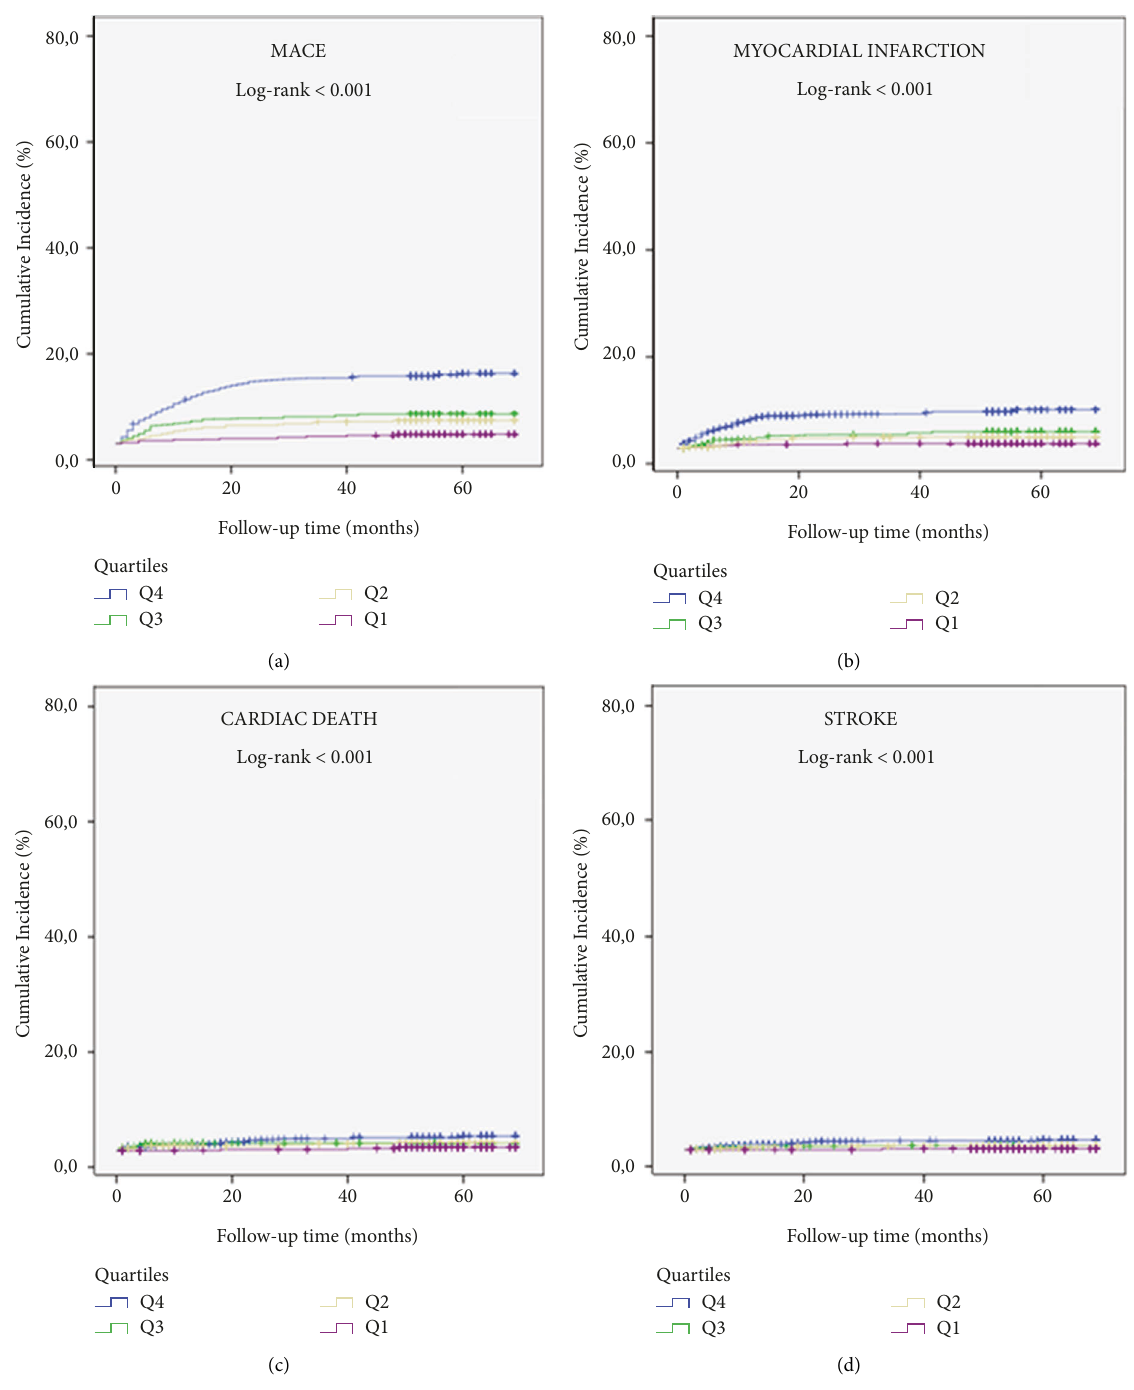
Figure 6: Kaplan–Meier survival curves of cumulative incidence of (a) MACE, (b) myocardial infarction, (c) cardiac death, and (d) stroke in patients according to their C-peptide quartiles (Q4-blue line; Q3-green line; Q2-yellow line; Q1-Purple line); MACE, major adverse cardiovascular